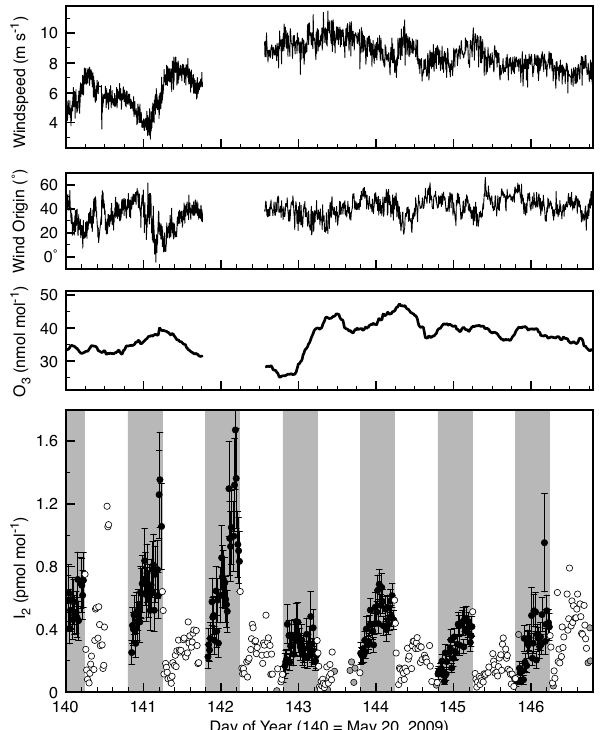
Fig. 3. Wind speed, wind direction, O 3 mixing ratios, and I 2 mixing ratios at CVAO during one week in May 2009. I 2 error bars are one standard error. Open circles are daytime points which likely include a measurement artifact and should be considered upper limits. Grey filled circles are points below the detection limit. The dark vertical bars represent nighttime hours. The gap in non-I 2 data about day 142 was due to power loss to some of the instruments.